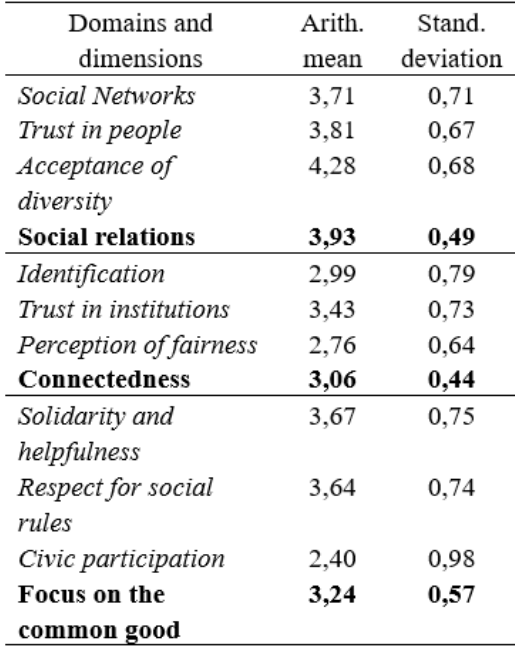
Table 2. Results of the assessment of the social cohesion level in the university com-